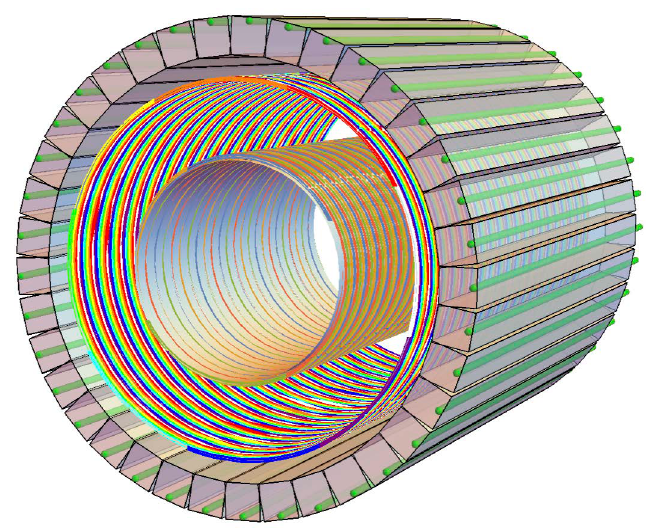
Figure 5. 3D drawing of 2-layer barrel scintillating-fiber tracker, surrounded by outer scintillator-bar hodoscope used for trigger purposes and to break reconstruction